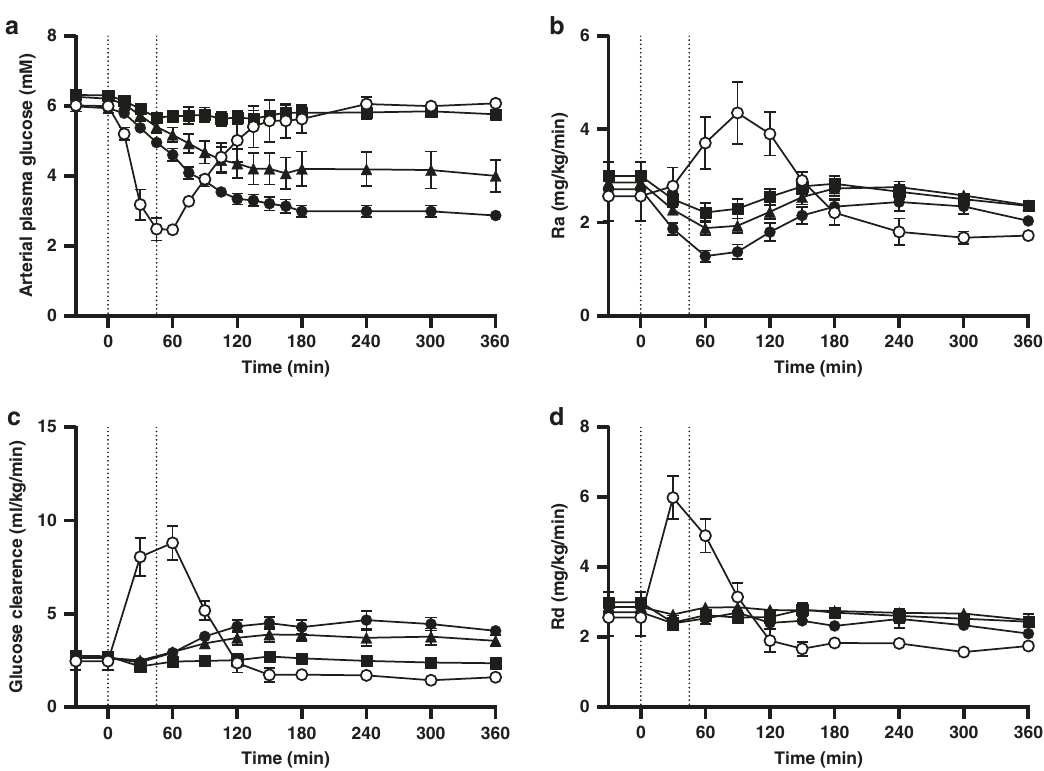
Fig. 6 Assessment of hypoglycaemia after overdosing in dogs. Plasma glucose lowering, and dynamics of glucose turnover obtained from an over-dose study with OI320 performed in healthy and conscious mongrel dogs on day four after once daily IV dosing with a maintenance dose of OI320 (40 pmol/ kg/min for 45 min) for three days. The three days of pre-treatment was performed to mimic a steady-state situation. a The hypoglycaemic response in dogs to 45 min intraportal infusion of IO320 in three different doses (40 (black squares), 80 (black triangles) or 120 (black circles) pmol/kg/min) ( n = 5 for each doses; independent experiments; mean + / − S.E.M.) or human insulin (white circles) at 24 pmol/kg/min ( n = 3; independent experiments; mean + / − S.E.M.; independent experiments). The dose of human insulin was set to 60% of the maintenance dose of OI320 (40 pmol/kg/min) in order not to induce too severe hypoglycaemia. b The dynamics of glucose appearance (Ra, hepatic glucose production) and d glucose disappearance (Rd, glucose uptake mainly by muscle and fat). c Changes in glucose clearance. The vertical lines in Fig. 6a – d indicate the portal insulin infusion period from 0 – 45